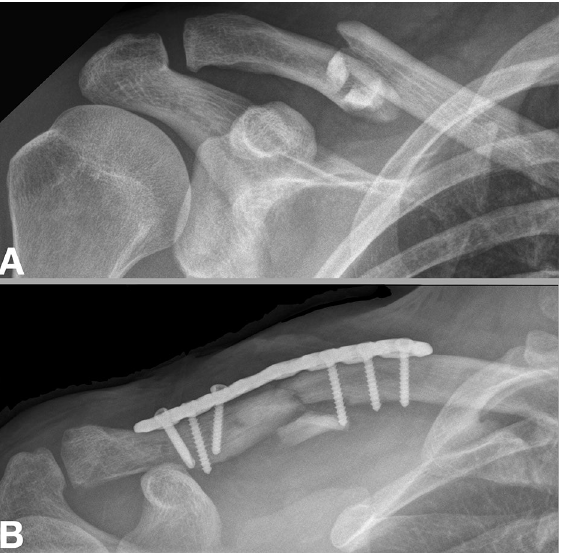
Figure 1. Radiographic anteroposterior images (right shoulder) of a 30-year-old female following a motorcycle accident demonstrating a midshaft clavicle fracture and fracture fixation with a superior plate. ( A ) Displaced midshaft clavicle fracture, ( B ) plate fixation with a superior